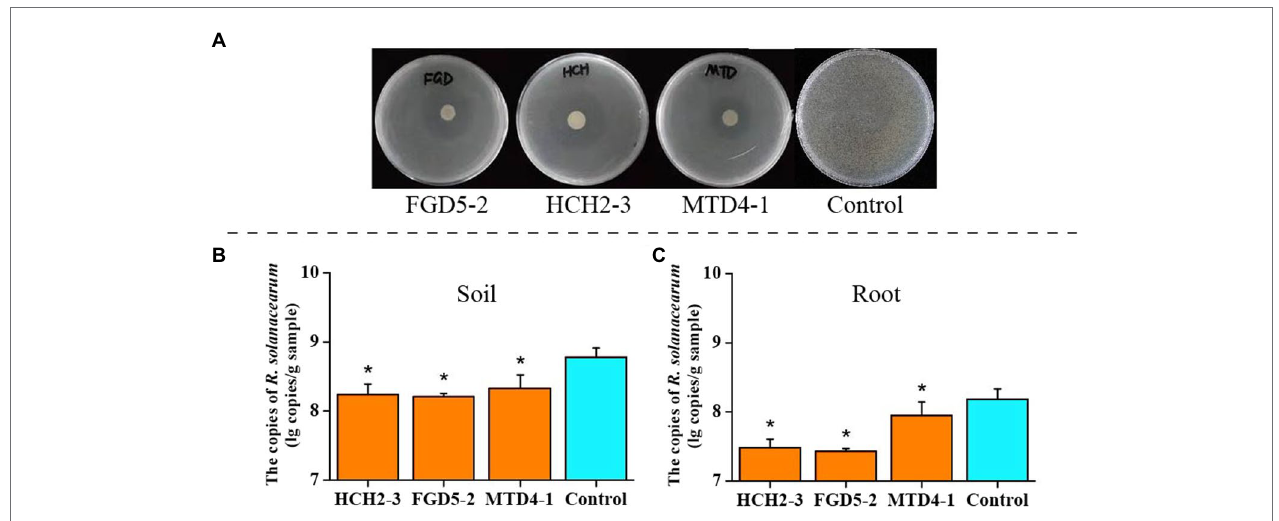
FIGURE 1 | Inhibitory effect of three Pseudomonas strains on R. solanacearum . (A) Inhibition against R. solanacearum on plates. (B) The absolute abundance of R. solanacearum in soil samples. (C) The absolute abundance of R. solanacearum in root samples. Asterisks in (B,C) indicated there was significant difference between the control and inoculation groups. * p < 0.05. HCH2-3, P. koreensis ; FGD5-2, P. lurida ; and MTD4-1, P. rhodesiae